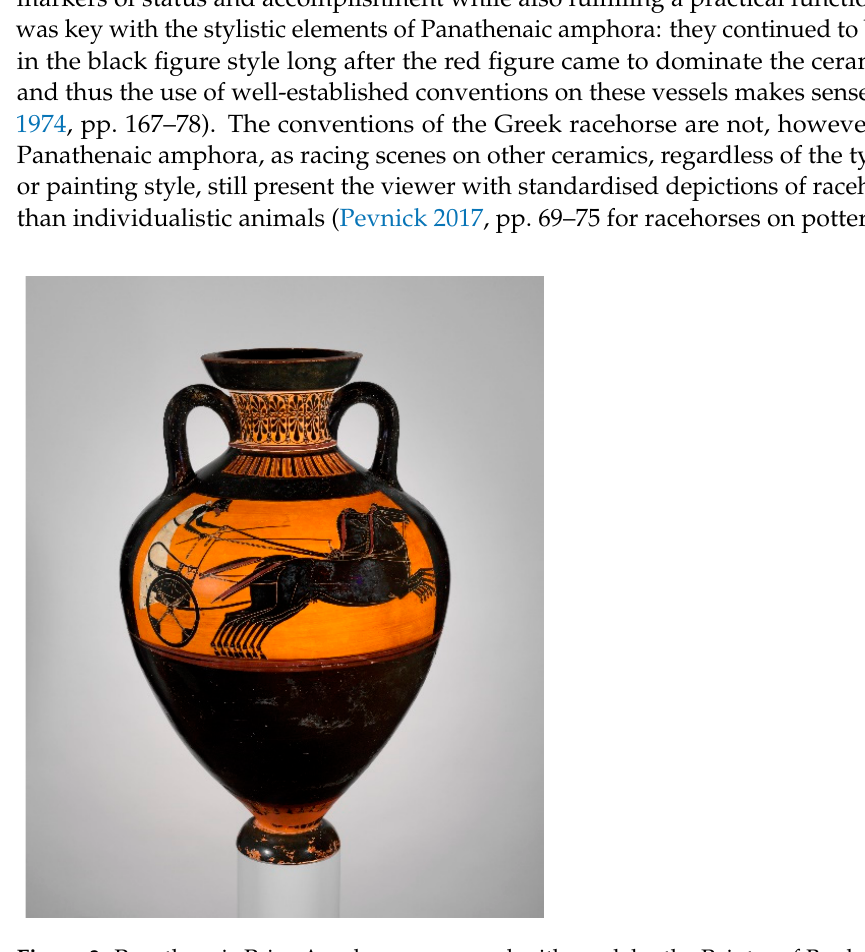
Figure 3. Panathanaic Prize Amphora, compared with work by the Painter of Bouloggne 441. Ca. 520 BCE. Metropolitan Museum of Art, Fletcher Fund 19576. Inv. no.